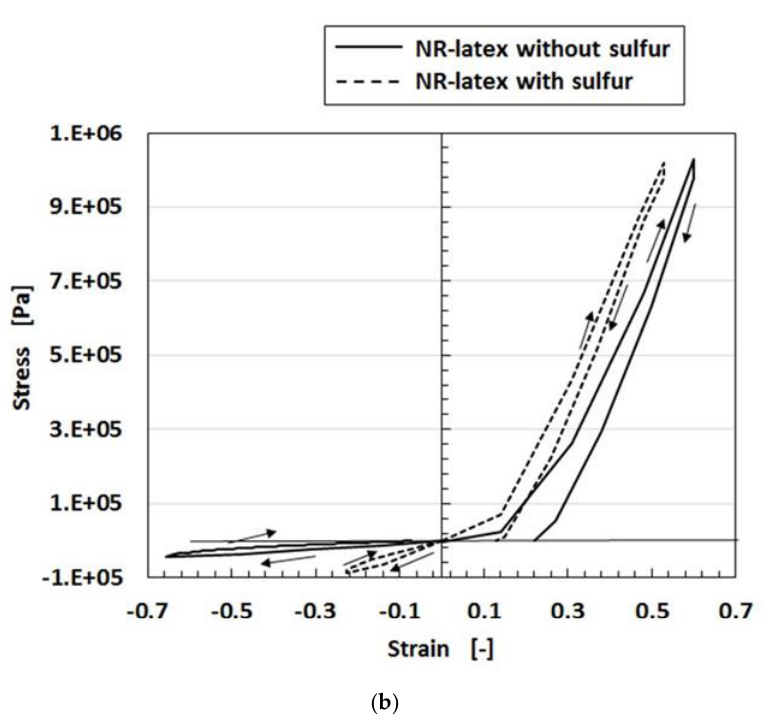
Figure A8. Comparison of piezoresistivity of NR-latex with and without sulfur; ( a ) voltage of MCF rubber sheet by compression; ( b ) relationship between strain and stress.